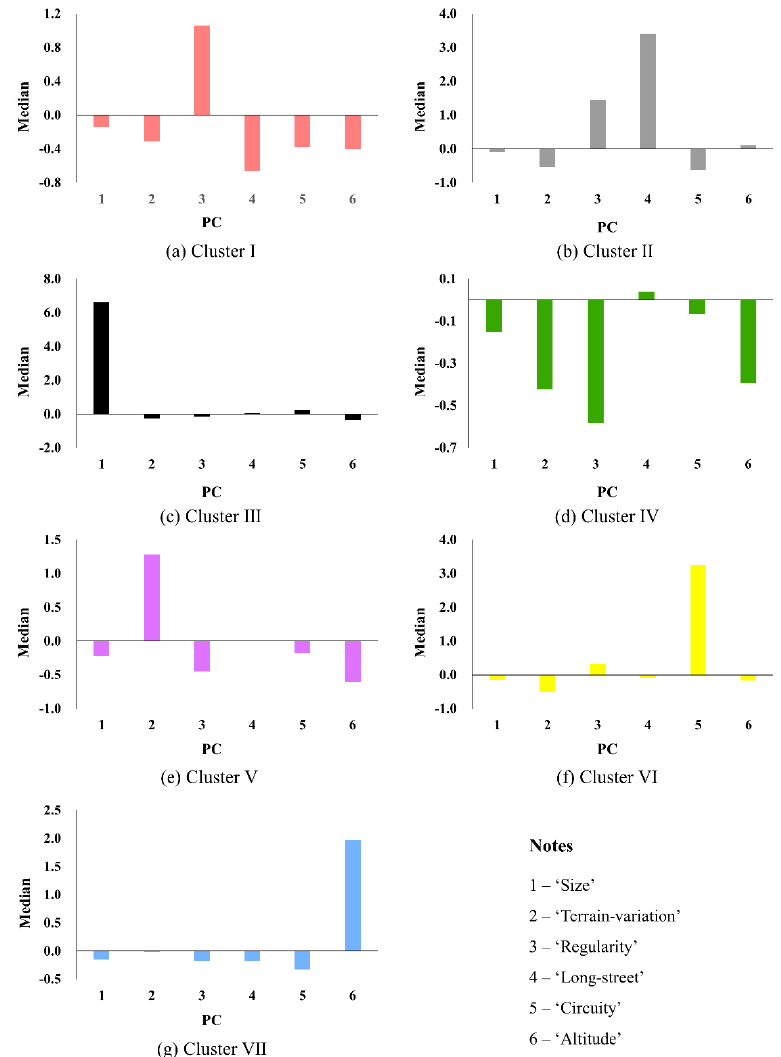
Figure 4. The medians of six PCs for cities in each cluster.